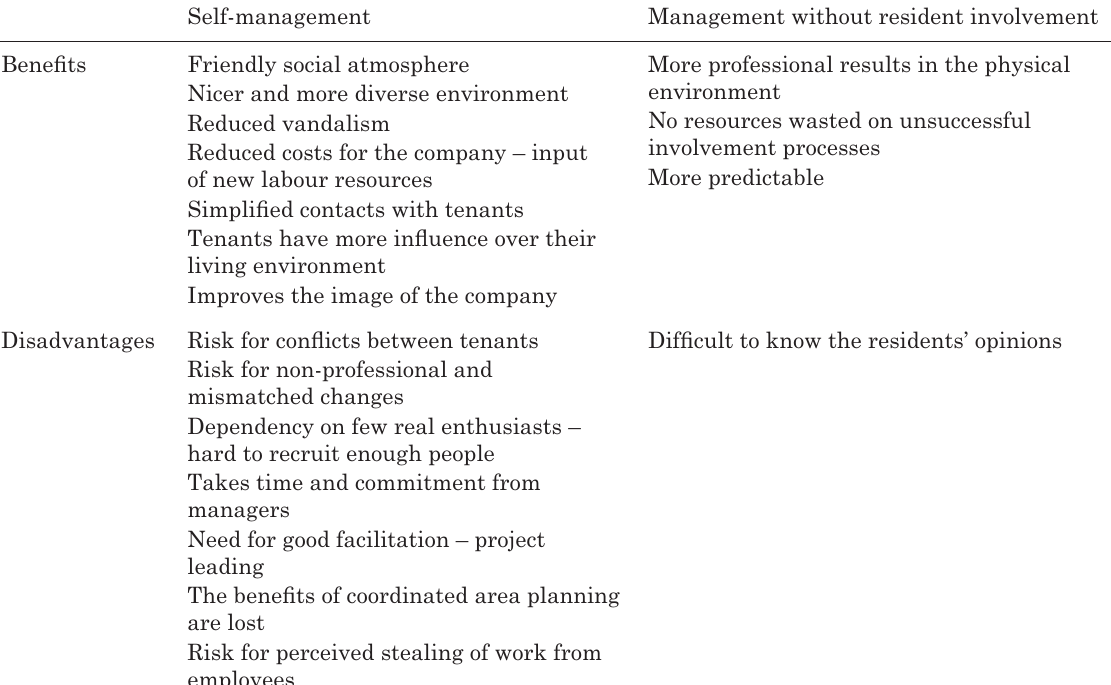
Table 4. Summary of arguments for and against self-management and management without resident involvement